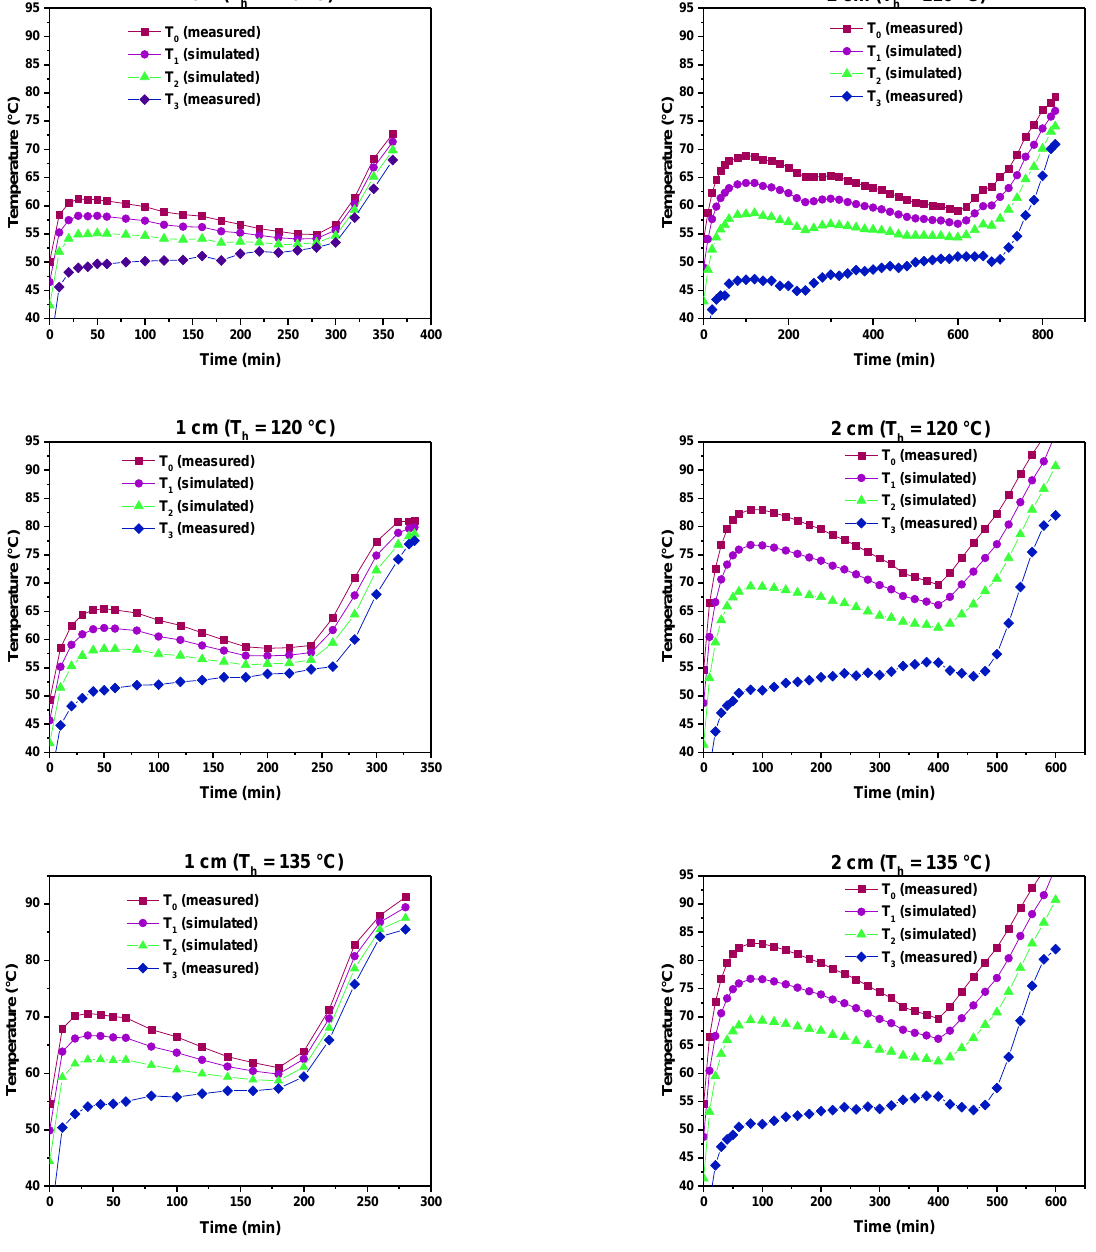
Figure 7. Measured and simulated temperatures inside the PHWWC drying sample for different temperatures T h (110, 120 and 135 °C) and thicknesses (1, 2 cm).